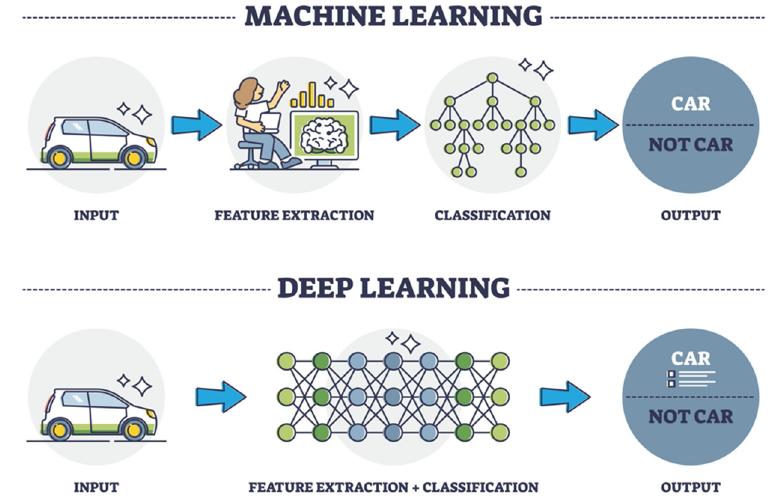
Figure 7. Machine learning vs. Deep learning (VectorMine/Shutterstock.com, accessed on 27 April 2022).